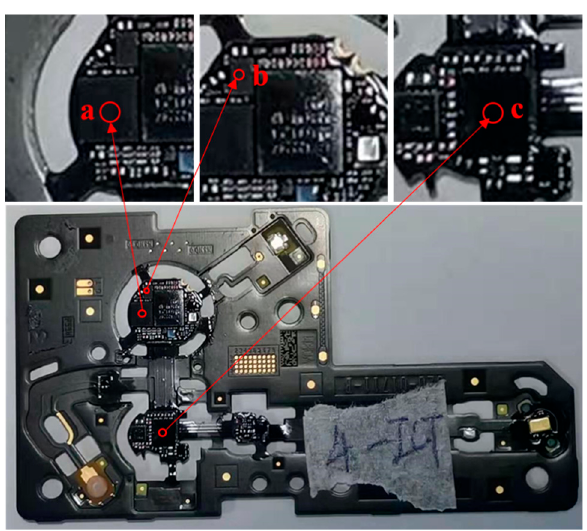
Figure 12. Measurement experiment of film thickness in different areas on PCB.